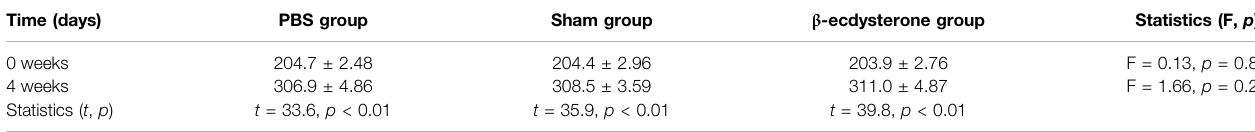
TABLE 4 | The weight of rats in different groups (0 and 4 weeks after surgery; n = 5).